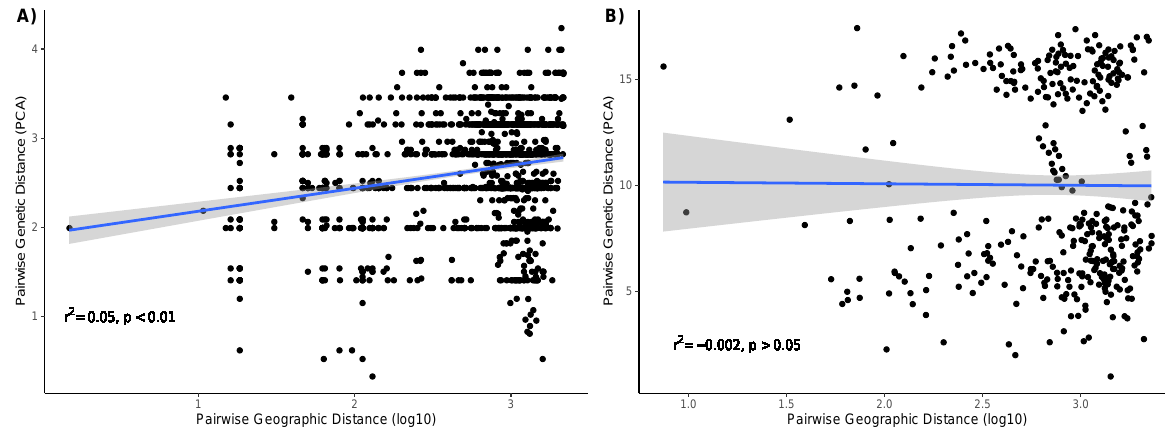
Figure 5. Correlation between genetic distance of ( A ) microsatellites and ( B ) SNPs and logarithm of geographical distance of all pairwise combinations of